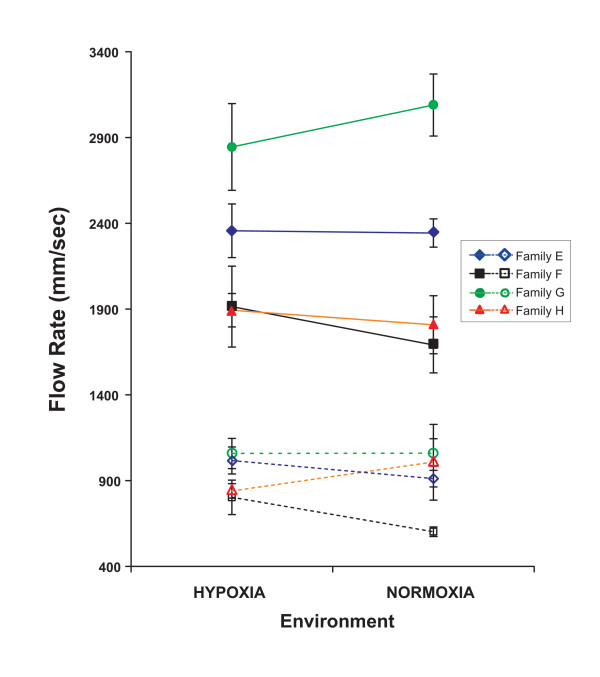
Mean red blood cell velocity by family and environment. A) Family mean arterial red blood cell flow rate is presented for larvae reared in normoxic and hypoxic environments. B) Family mean venous (open symbols) red blood cell flow rate is presented for larvae reared in normoxic and hypoxic environments. Error bars represent one standard error. Environment was not a significant source of variation in flow rate, while family was a significant source of variation in both arterial and venous flow rates.